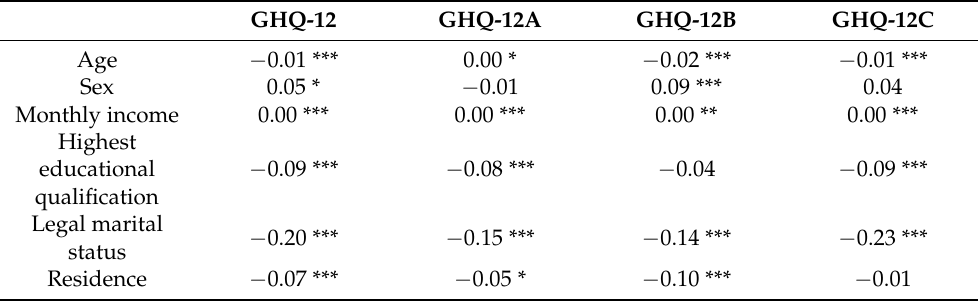
Table 3. The estimates (b) of linear models trained based on demographic predictors. All numbers are rounded up to two decimal